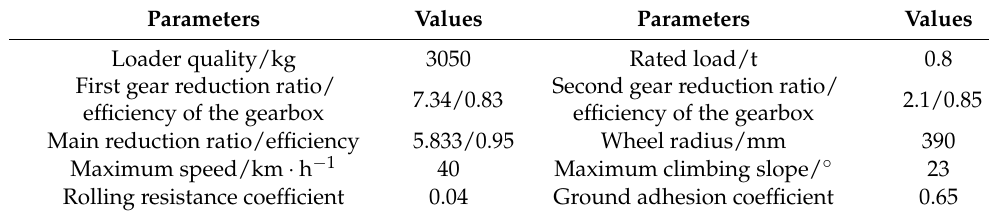
Table 1. ZL08 pure electric loader